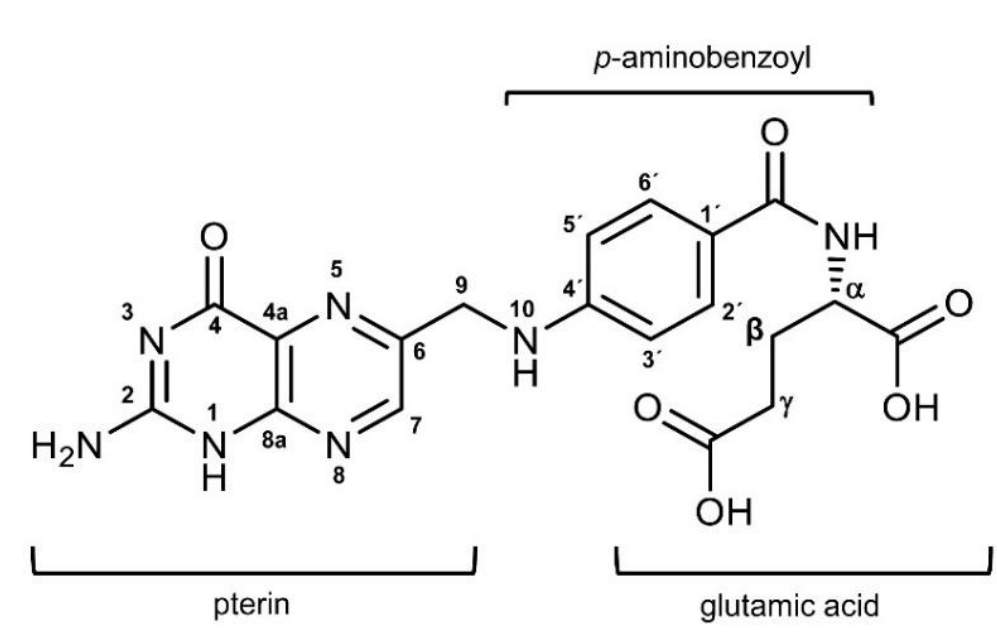
Figure 1. Structure of folic acid.